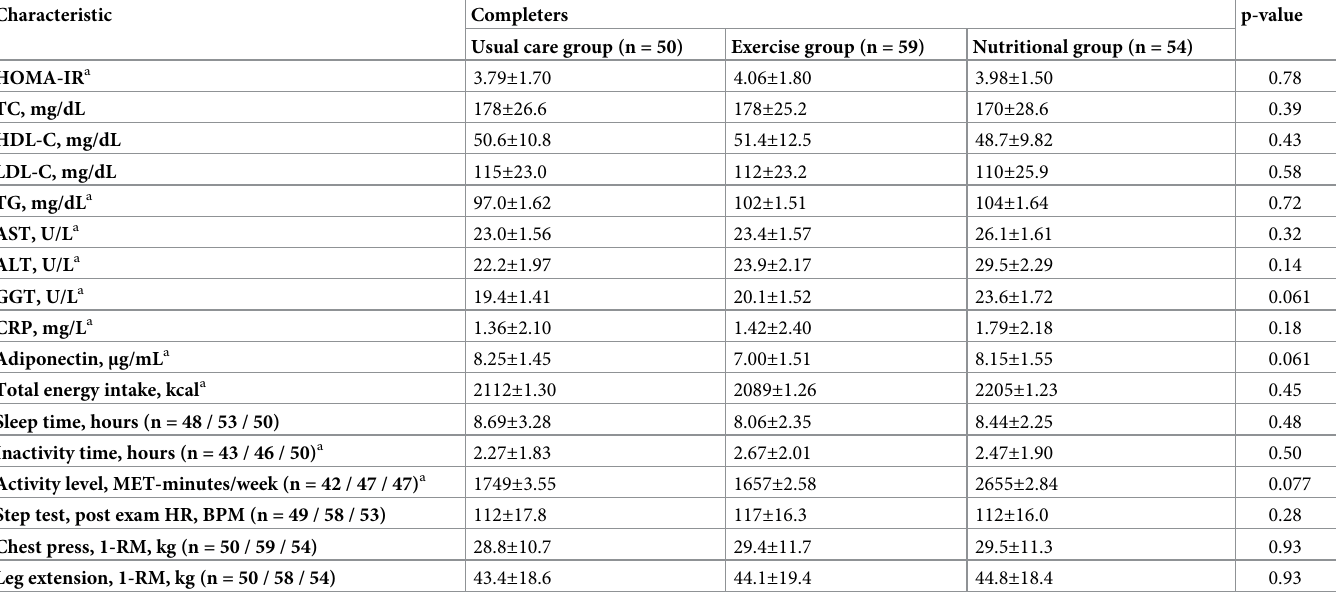
Table 2. Baseline laboratory test results, lifestyle measurements, and fitness test results of completers.